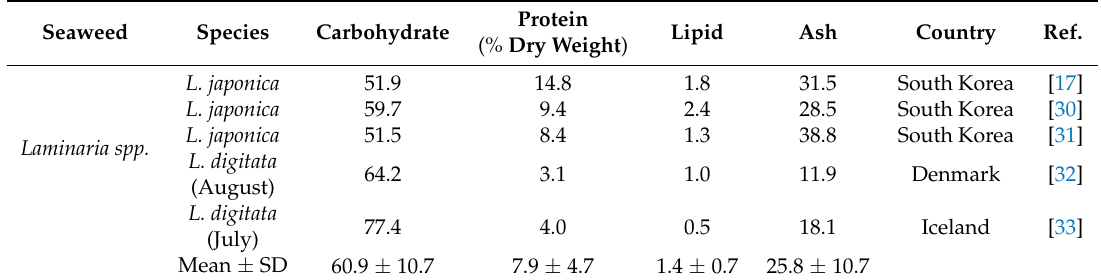
Table 1. Chemical composition of dried Laminaria